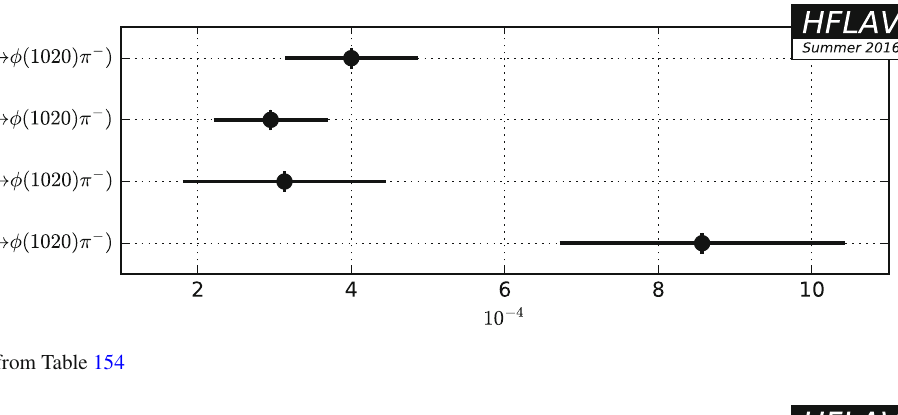
Fig. 123 Summary of the averages from Table 153